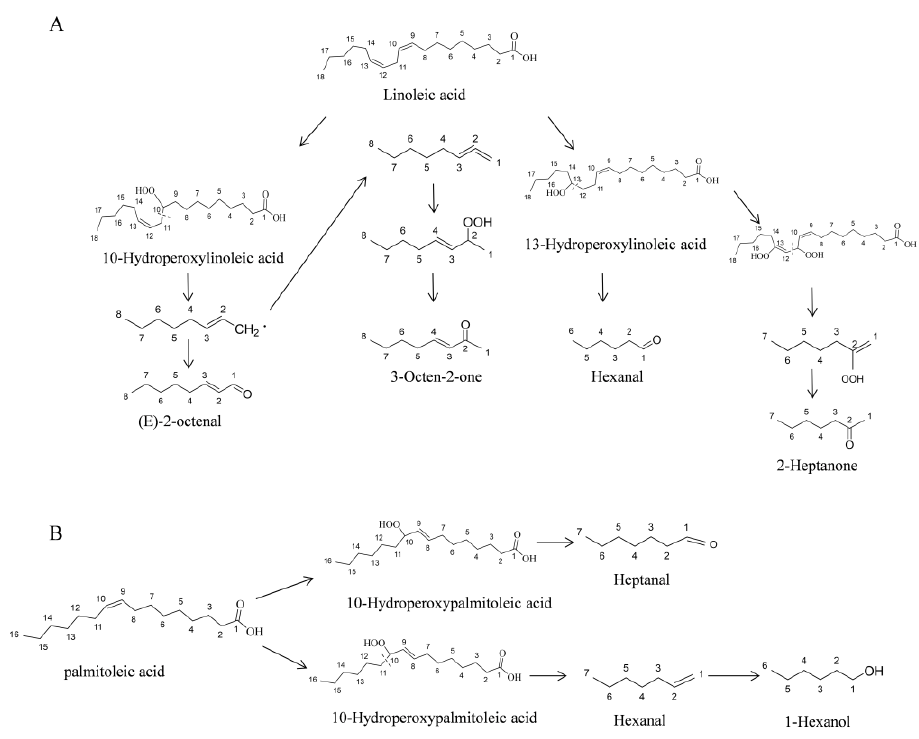
Figure 5. Proposed formation pathways of the volatiles produced from linoleic acid ( A ) and palmitoleic acid ( B ).